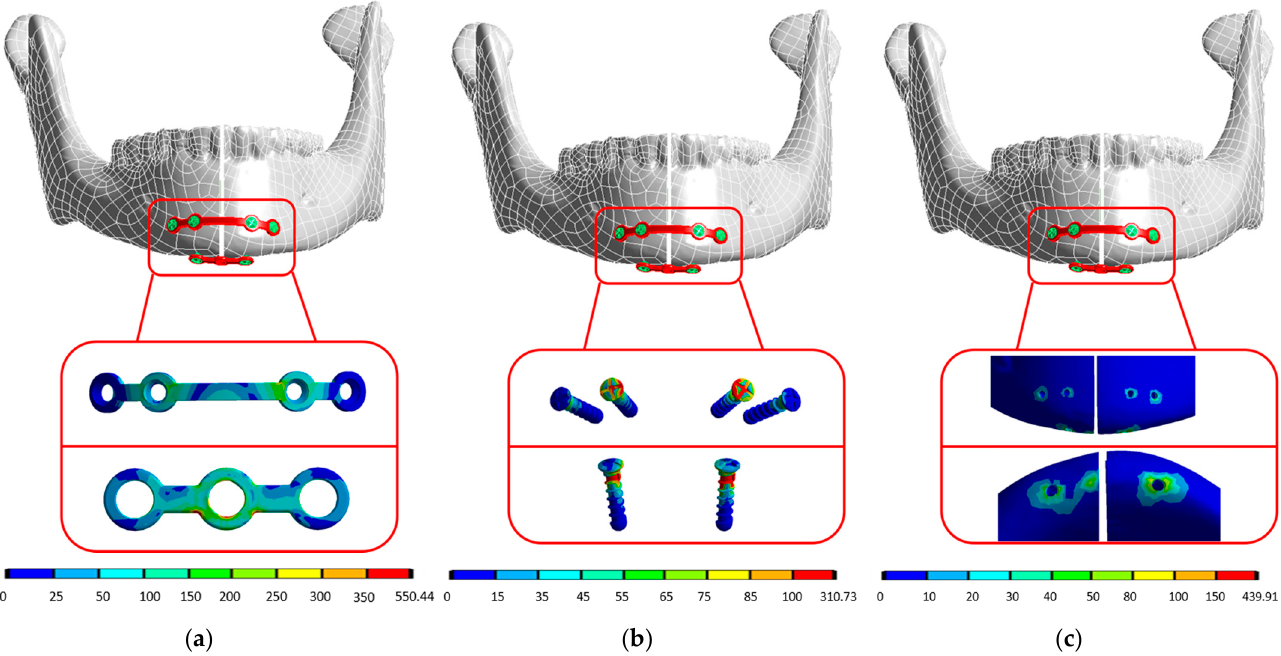
Figure 3. Stress distribution of Per4H4HP. ( a ) plate; ( b ) screws; ( c ) screw holes. (Unit: